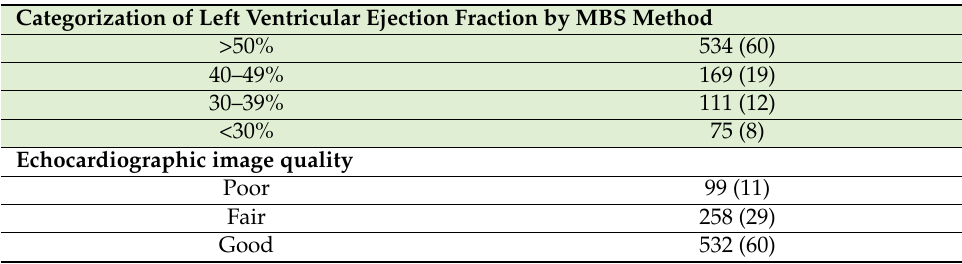
Table 4. Echocardiographic Characteristics of the Studied Population ( N = 889). Categorization of Left Ventricular Ejection Fraction by MBS